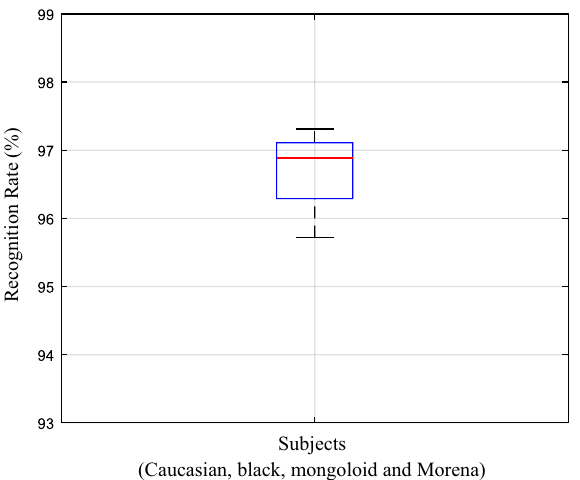
Figure 10. Algorithm accuracy under different skin colors of participants; the composition ratio of each skin color is